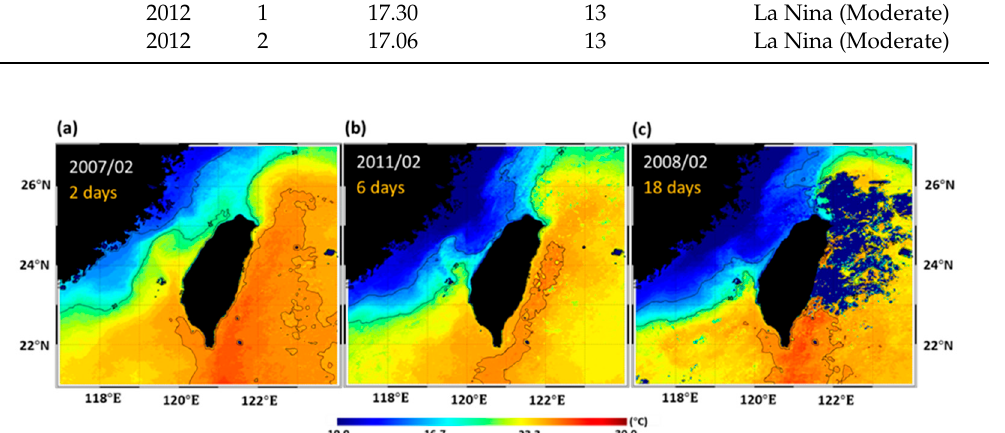
Figure 5. Contours of 20 °C isotherms in the Taiwan Strait (TS) during the case studies of ( a ) category A, ( b ) category B, and ( c ) category C during winter.